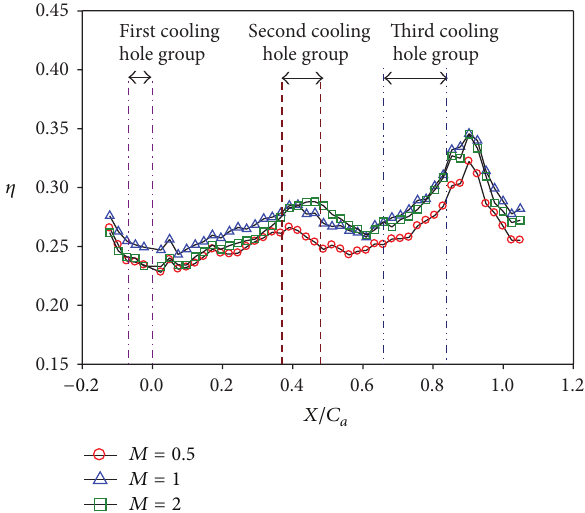
Figure 13: Effect of blowing ratio at low turbulence intensity ( 𝑆/𝐶 = 0 %, Re = 124000 , and T . I . = 1.8